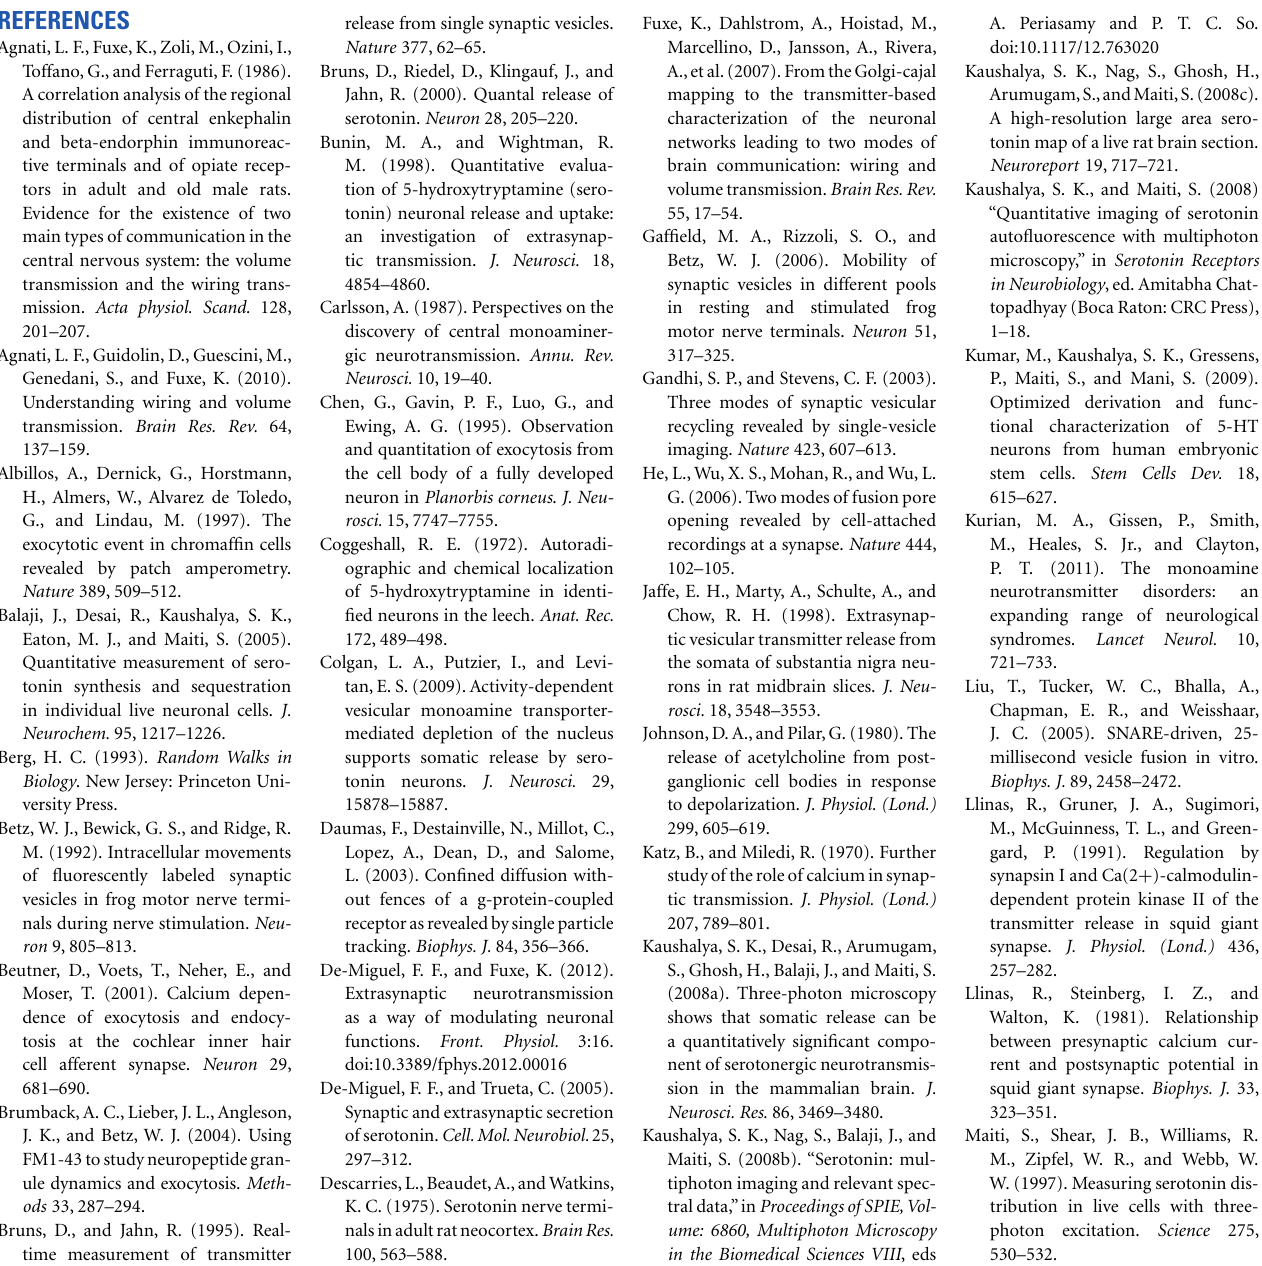
Video S1 |Three photon excitation microscopy of a single optical slice shows false color intensity coded images of serotonin fluorescence spots in the cell body and in the processes of a serotonergic neuron in a cultured brain-slice containing the raphe, before depolarization. Twenty frames recorded at